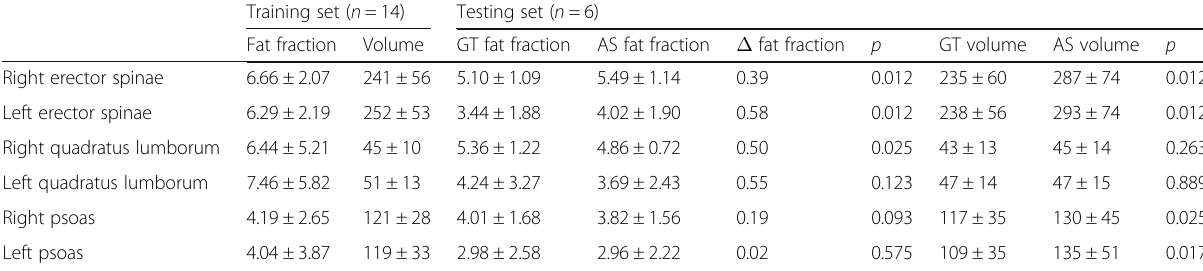
Table 1 Mean and standard deviation of PDFF (%) and volume (cm 3 ) of each muscle compartment in the training and test dataset Training set ( n =